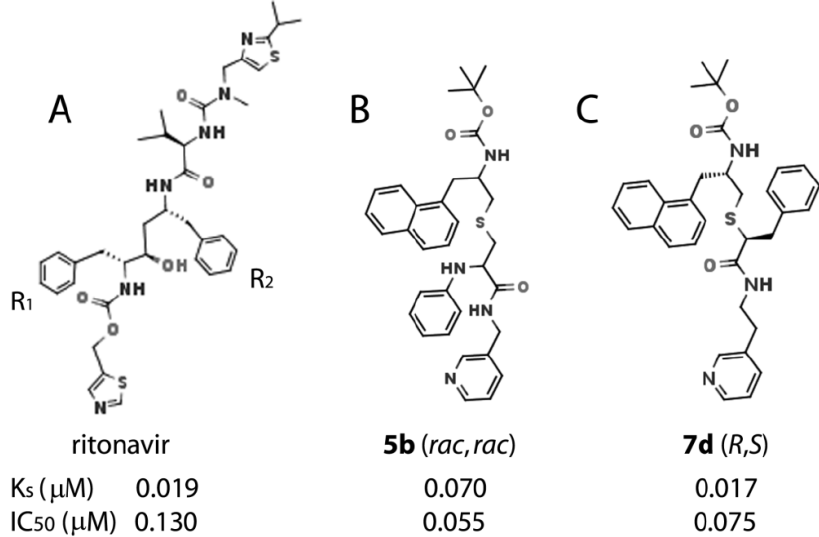
Figure 1. Chemical structures of ritonavir ( A ), a highly potent CYP3A4 inhibitor in clinical use, and the best two rationally designed inhibitors from series IV [10] ( B , C ). The R 1 and R 2 side-groups are indicated. If the central hydroxyl group of ritonavir is removed, the phenyl side-groups would be in R/R configuration.